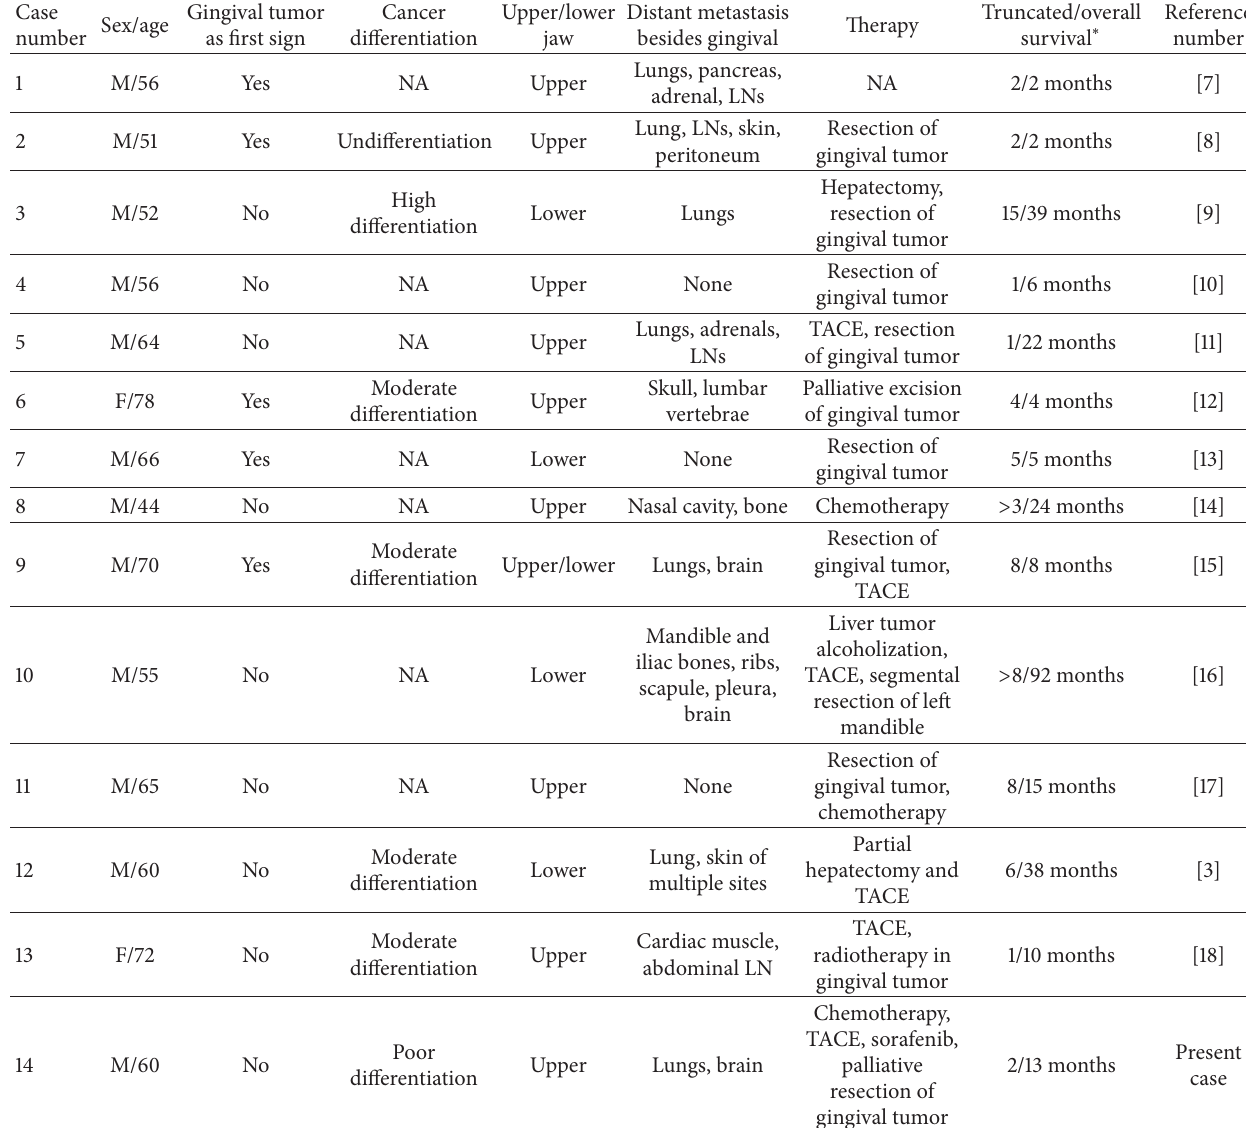
Table 1: Cases of gingival metastasis by hepatocellular carcinoma with survival data in English literatures.